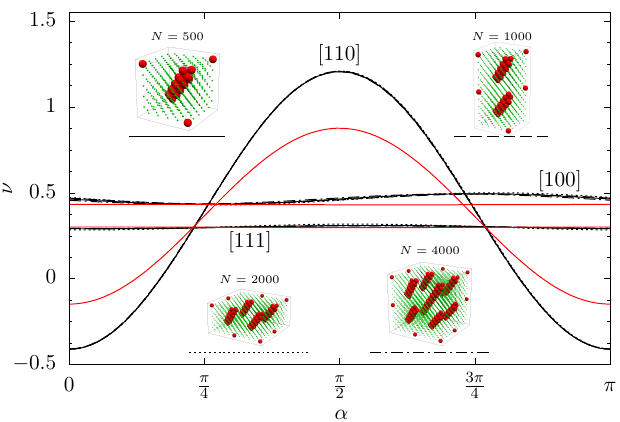
Figure 4. Poisson’s ratio in three crystallographic directions for various size of the system ( N = 500, 1000, 2000, and 4000) as a function of the angle α (with c = 7%, p ∗ = 100, κσ = 10 and β(cid:101) = 20). Red lines represent Poisson’s ratio in the respective crystallographic directions of the system without nanoinclusions.